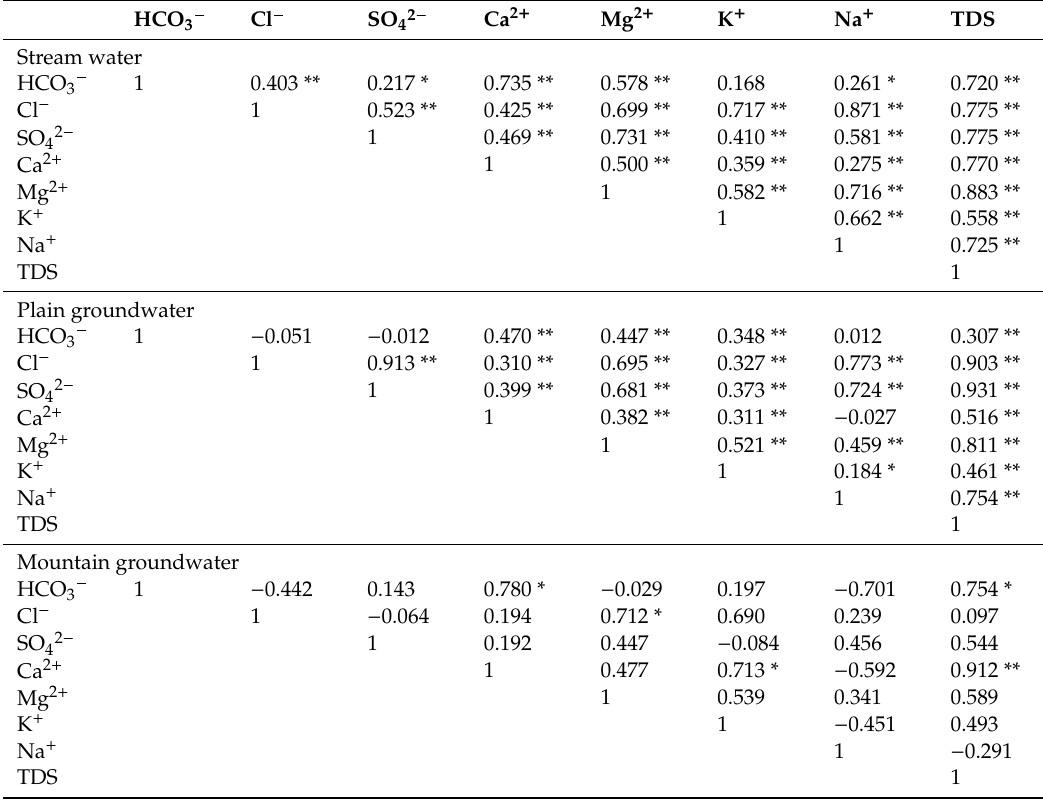
Table 2. Correlation matrix for the major parameters in stream water and